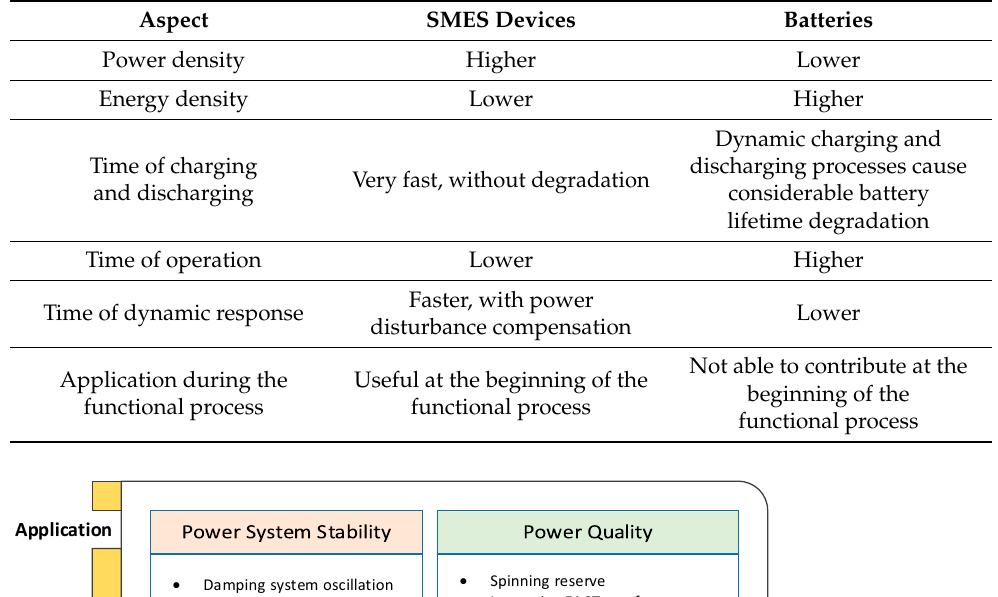
Table 3. Comparison between SMES devices and batteries in power system applications.